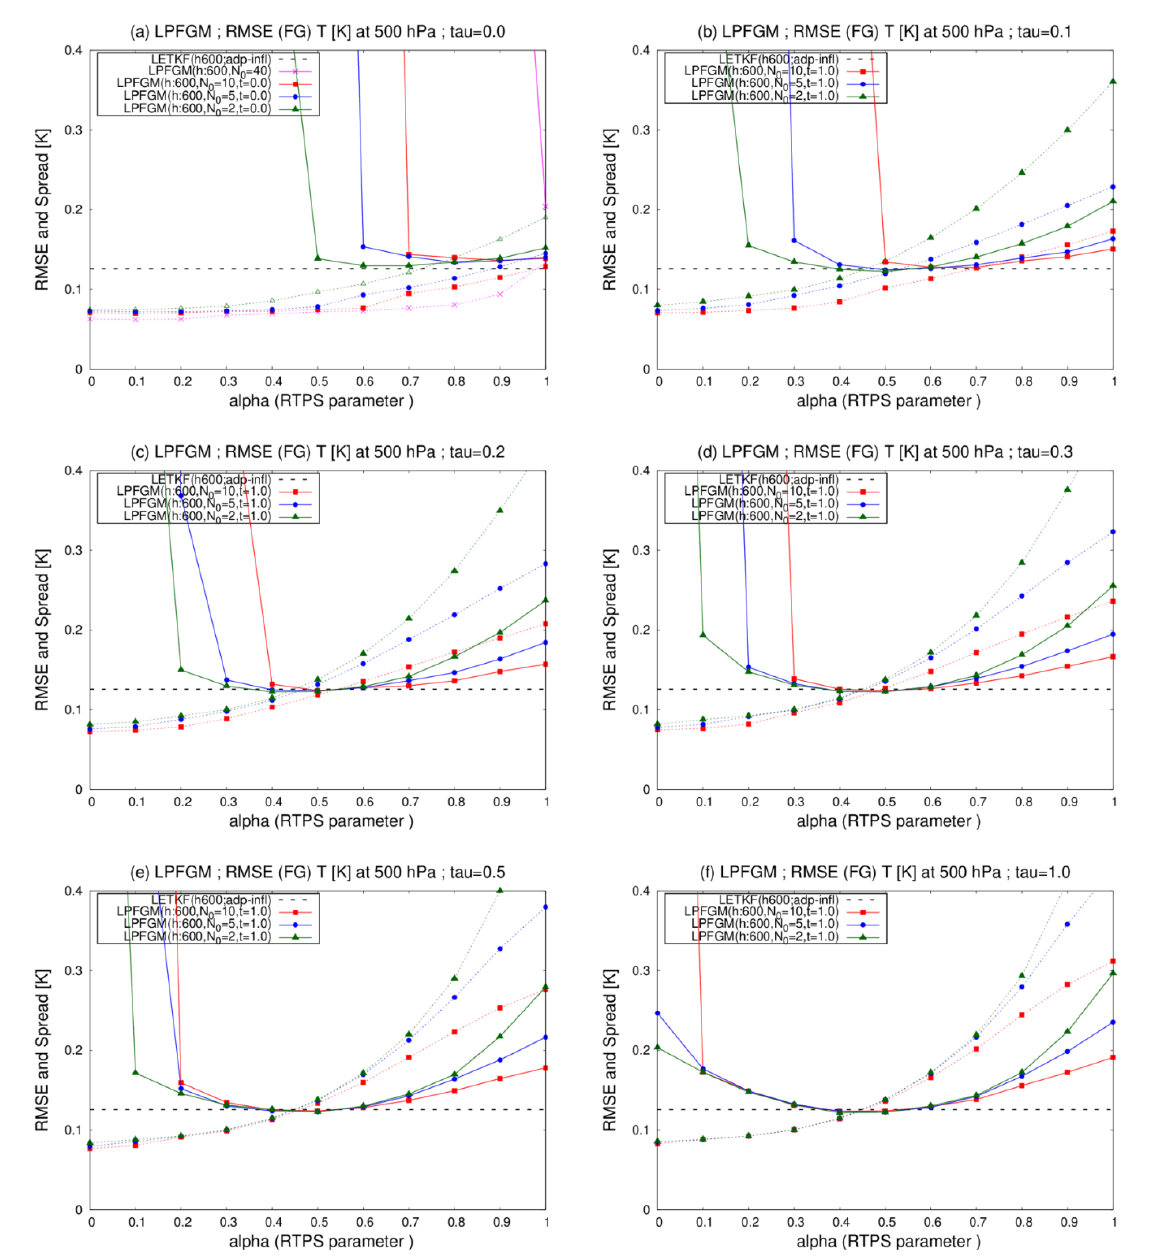
Figure 7. Similar to Fig. 5 but for the LPFGM with REG2 and 600km localization scale. Magenta, red, blue, and green lines show the cases with N 0 = 40, 10, 5, and 2, respectively. Dashed lines represent RMSE of LETKF (0.1257K). Panels show the LPFGM with forgetting factors for (a) τ = 0 . 0, (b) τ = 0 . 1, (c) τ = 0 . 2, (d) τ = 0 . 3, (e) τ = 0 . 5, and (f) τ = 1 . 0, respectively.